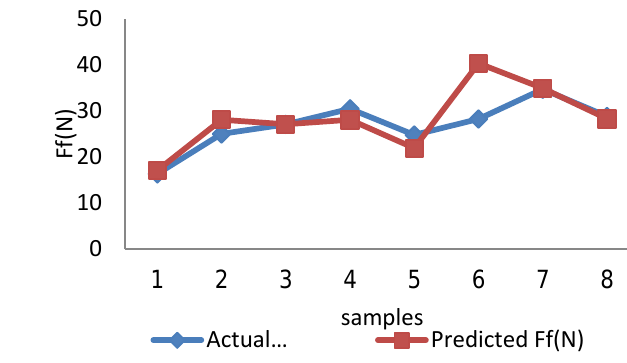
Fig. 6. Comparison of Ra values obtained from actual measurements and ANN method-(sample No. Vs Ra(µm))